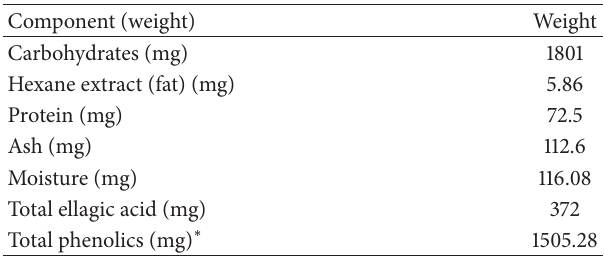
Table 1: Composition of POMx capsules 1